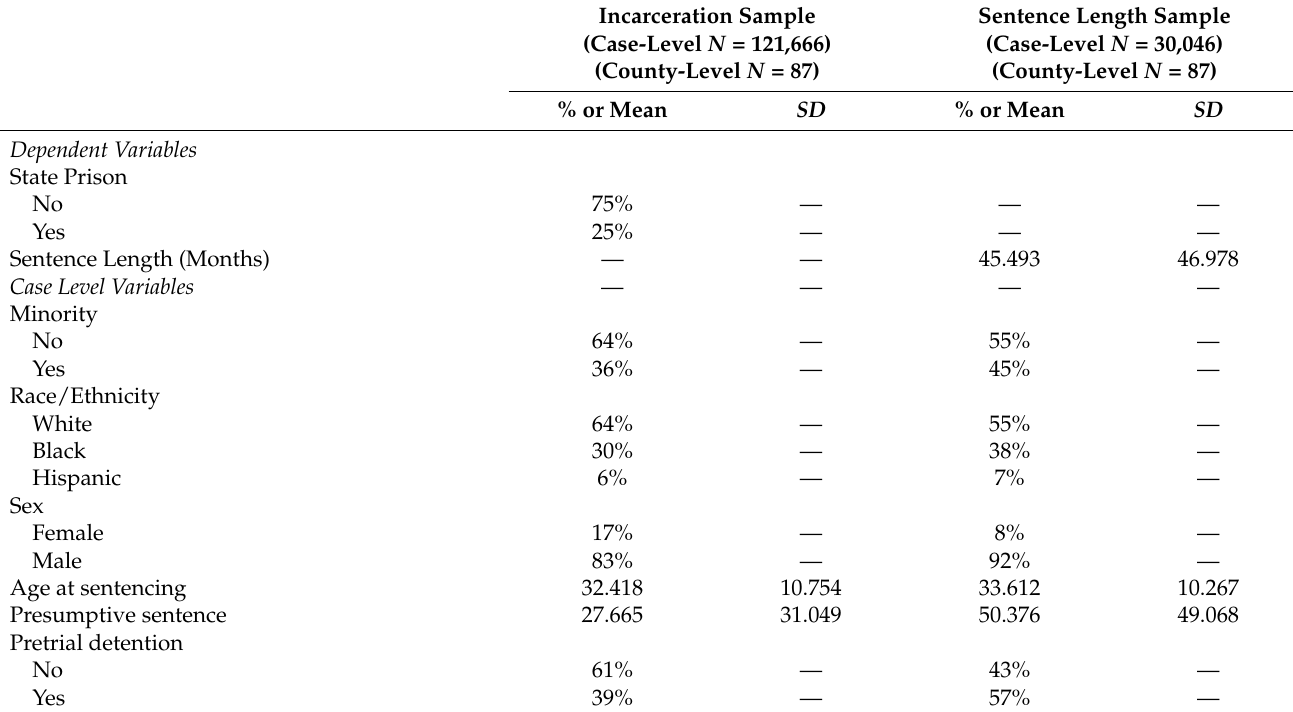
Table 1. Descriptive